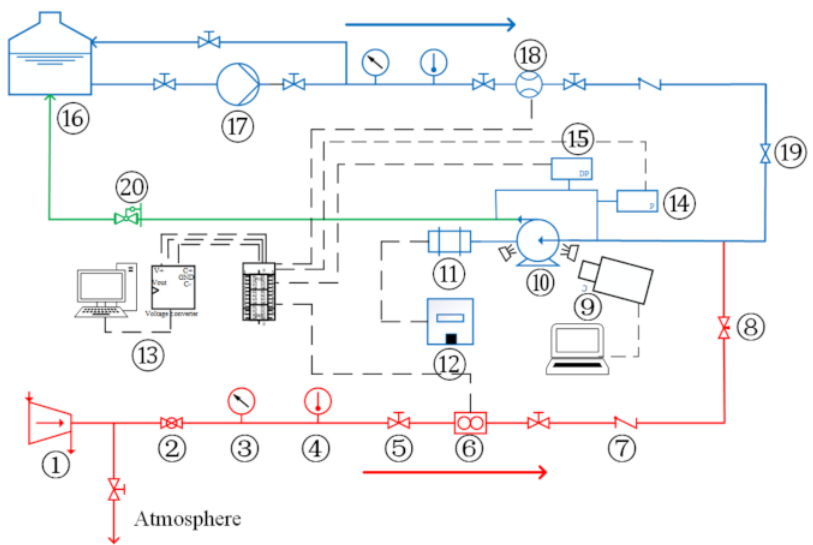
Figure 1. Schematic diagram of visual experimental system for gas–liquid two-phase flow of cen- trifugal pump: 1-air compressor; 2-ball valve; 3-pressure meter; 4-thermometer; 5-globe valve; 6-gas flowmeter; 7-check valve; 8-needle valve; 9-high speed camera system; 10-test pump; 11-electric motor; 12-frequency converter; 13-data acquisition system; 14-pressure transmitter; 15-differential pressure transmitter; 16-water storage tank; 17-multistage centrifugal pump; 18-water mass flowme- ter; 19-regulating valve; 20-back pressure regulator (gate